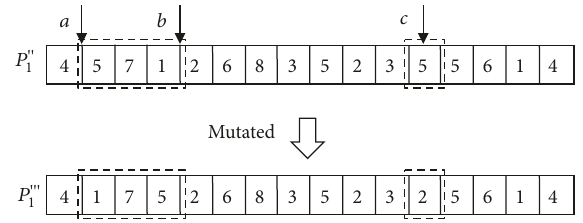
Figure 11: Sequence reversed mutation operator and basic bit mutation operator ( 𝑎 = 2 , 𝑏 = 4 , and 𝑐 = 12